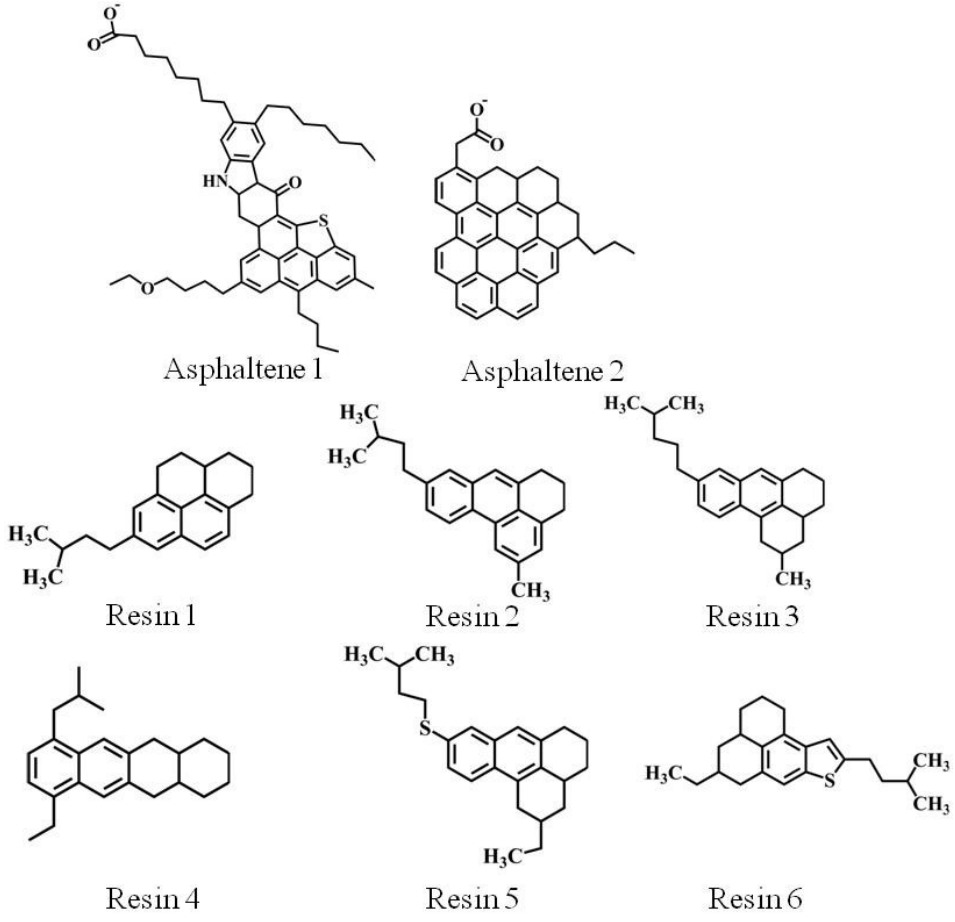
Figure 10. Asphaltene and resin molecules used in simulation.